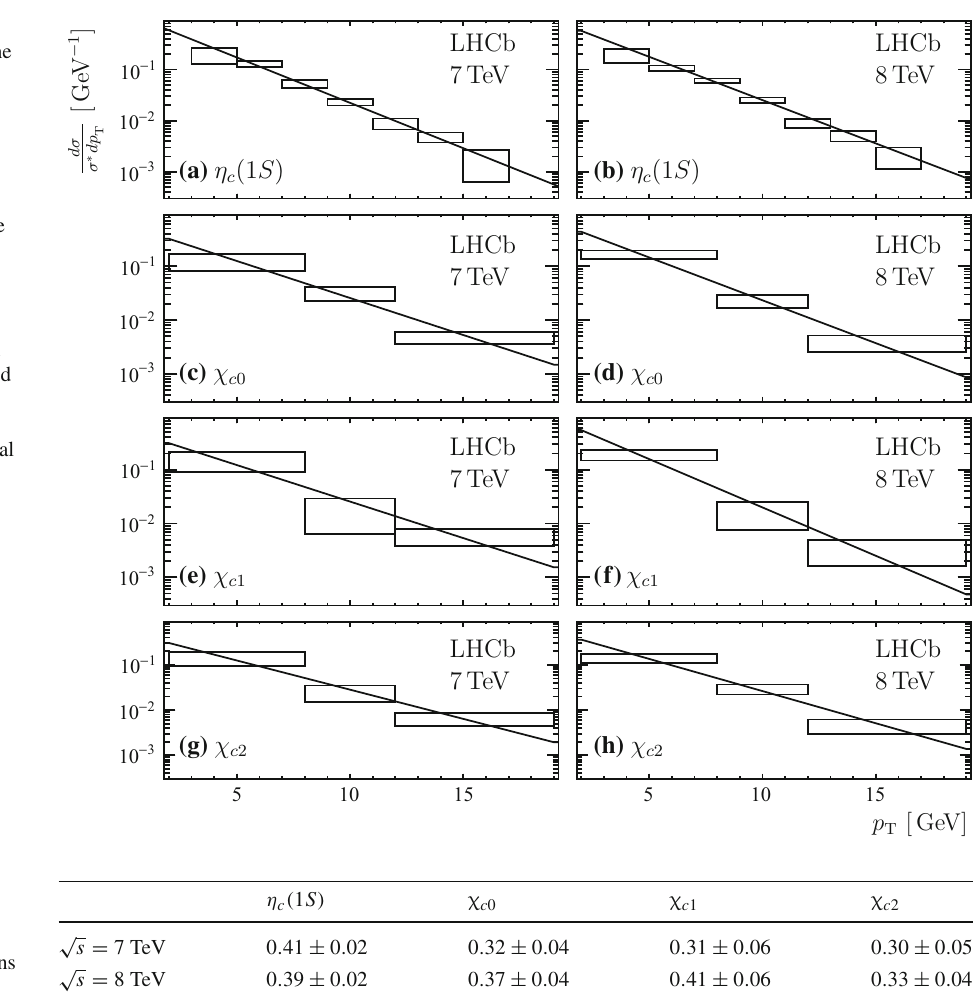
parameter in units of GeV − 1 from a fit to the p T spectra of